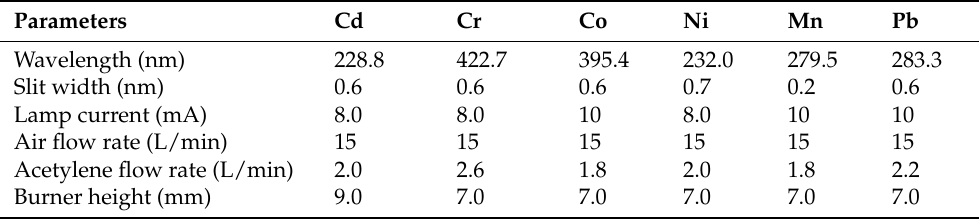
Table 4. Summary of operating conditions employed for the analysis of metals with atomic absorption